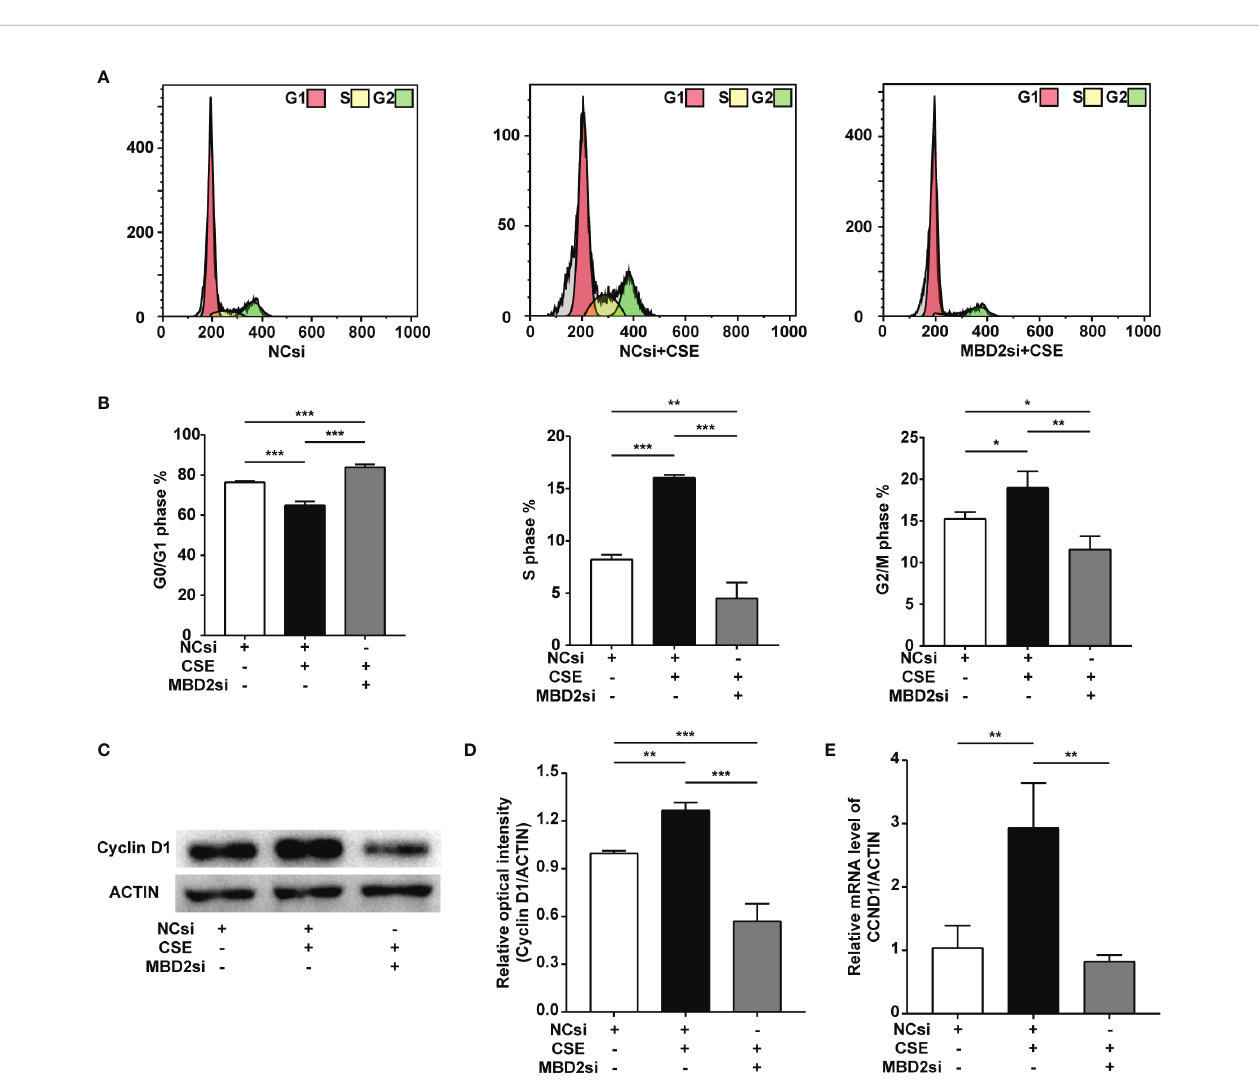
FIGURE 4 | Effect of MBD2si on cell cycle progression changes in CSE-induced HPASMCs. (A) Representative cell cycle progression images. HPASMCs were transfected with negative control siRNA (NCsi) or MBD2si, stimulated with 2% CSE or control solvent for 24h. MBD2si changed the cell cycle progression of the HPASMCs. The subsequently divided groups were the same. (B) Quantitation of the cell cycle progression. (C) MBD2si reduced cyclin D1 protein expression in CSE-induced HPASMCs. (D) Quantitation of the cyclin D1 bands based on the density. (E) Quantitation of the CCND1 gene ’ s mRNA expression. The data are presented as mean ± SD, n=3. * P < 0.05, ** P < 0.01, *** P <